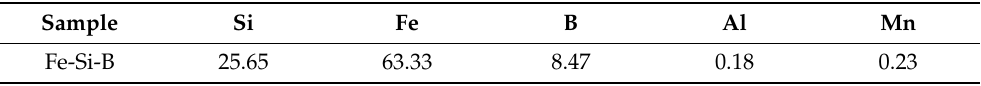
Table 1. Chemical composition of Fe-26Si-9B master alloy analyzed by ICP-MS (mass %).